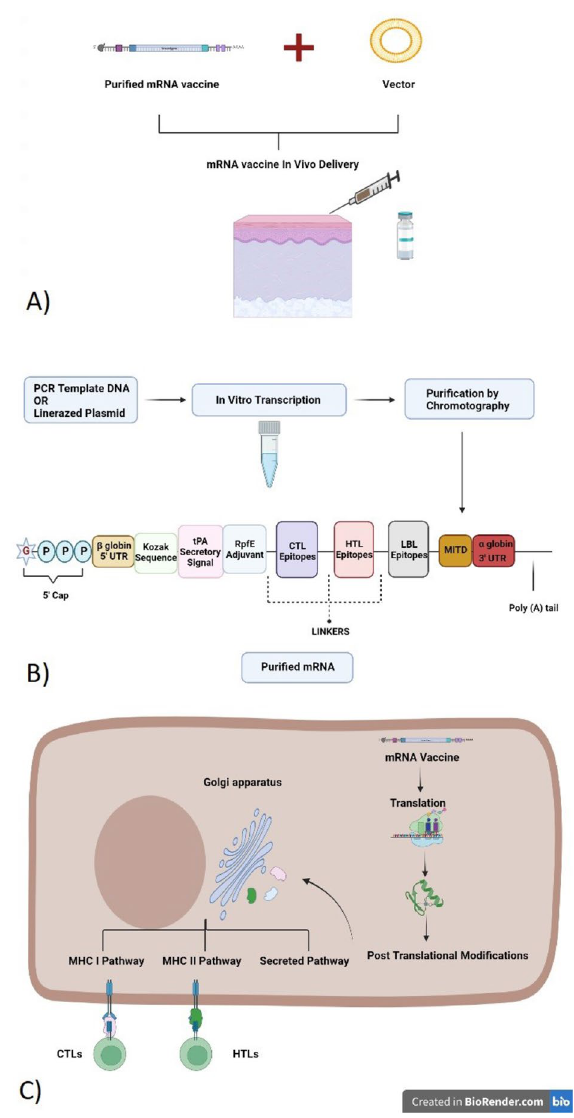
Figure 9. Proposed In vitro mechanism of production and In vivo method of delivery: ( A ) In vitro transcription of vaccine sequences ( B ) Vector-mediated delivery into the body and the mRNA transits to the cytosol ( C ) Mechanism of action of mRNA vaccine. Once it is translated into a protein in the cytosol, it undergoes PTMs and becomes a fully functional and properly folded protein. The tPA secretory signal and MITD sequences direct the peptides to specific compartments inside the cell (ER and Golgi apparatus) to either induce their secretion (LBL epitopes) or presentation (HTL and CTL epitopes) by the MHCI and